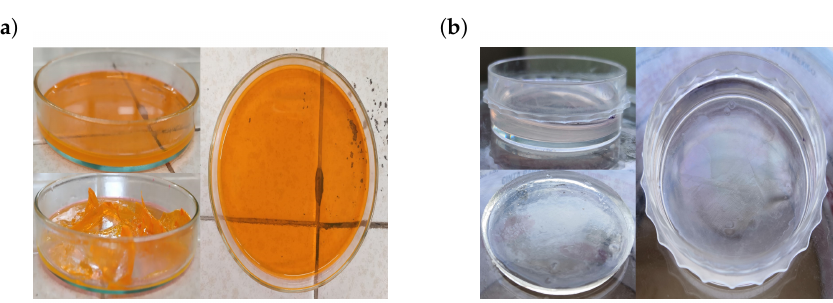
Figure 7. Hydrogel synthesis. ( a ) Using a concentration of 2 mM of Eosin “Y”. ( b ) Using a concentra- tion of 0.5 mM of Eosin “Y”. It is significant that with a higher concentration of Eosin “Y”, a more colorful sample is